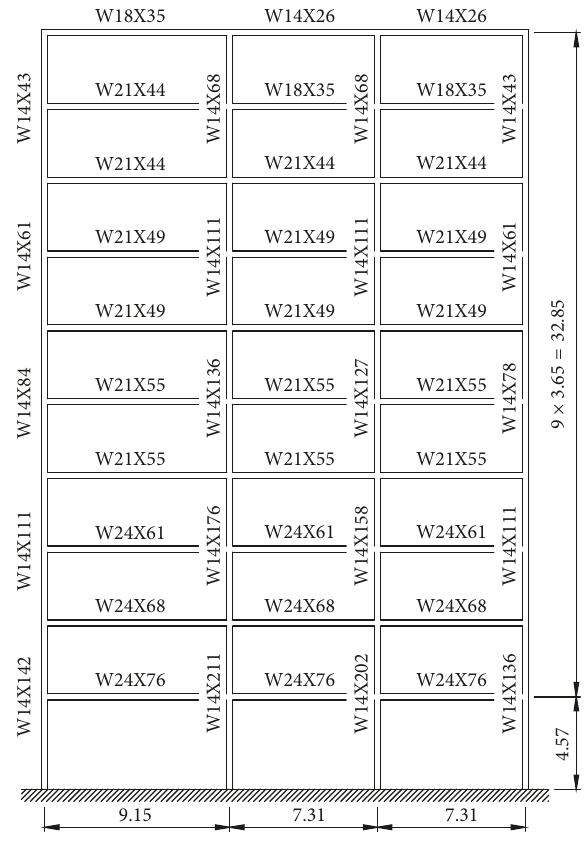
Figure 1: Planar steel frame (dimensions in m; adapted from [21]). Table 1: Statistical information about the random